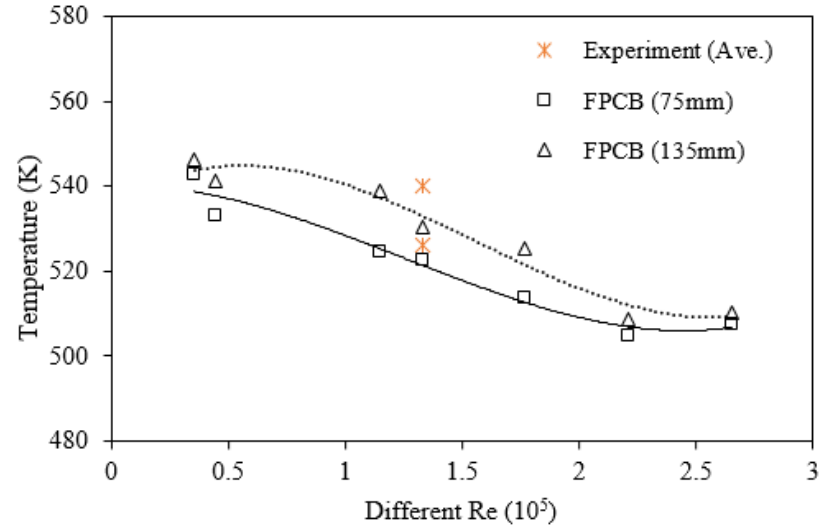
Figure 11. Temperature of FPCB at different Re and positions.